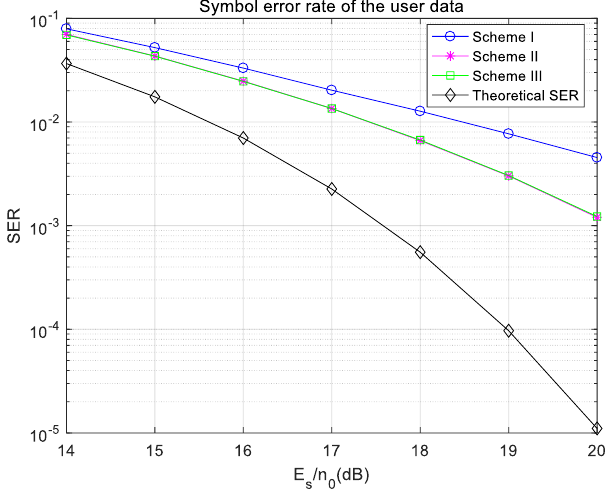
Figure 13. Symbol error rate of user data with a frequency offset in the Gaussian channel.